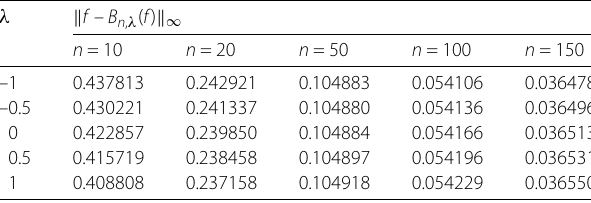
Table 1 The errors of the approximation of B n , λ ( f ; x ) to f ( x ) with different values of n and